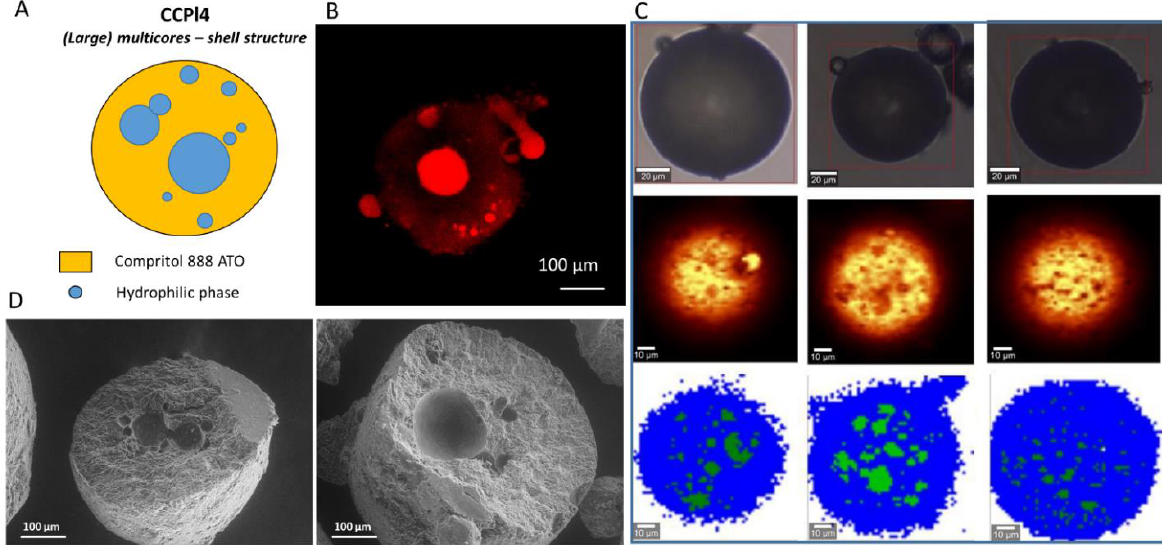
Figure 8. Internal morphology of CCPl4 b-MPs. Schematic illustration of particle structure ( A ). CLSM images, Rho (red color) solubilized in the hydrophilic phase was used as a fluorescent probe ( B ). Raman mapping images. The first row (at the top) shows visible pictures; the second row shows Raman images obtained based on the integration of characteristic Raman bands at 2852 and 2886 cm − 1 ; the third row shows Raman images: lipophilic phase (blue area) and hydrophilic phase (green area) ( C ). SEM images of cross-sections of CCPl4 b-MPs ( D ).